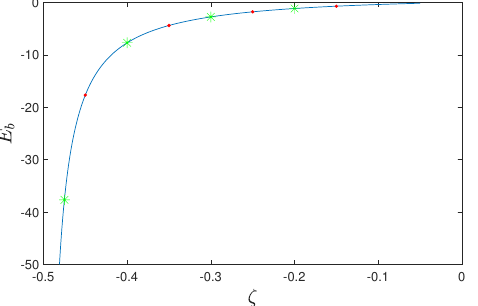
Figure 5. The surface energies versus the boundary parameters. The blue curves are the ones calculated from equation (4.10), while the red points ( ξ = − 0 . 1, θ = 0 . 3 π , φ = 0, θ ′ = 0 . 7 π and φ ′ = 0) and green stars ( ξ = − 0 . 1, θ = 0 . 17 π , φ = 0, θ ′ = 0 . 62 π and φ ′ = 0) are the ones obtained from Hamiltonian (1.1) with the BST